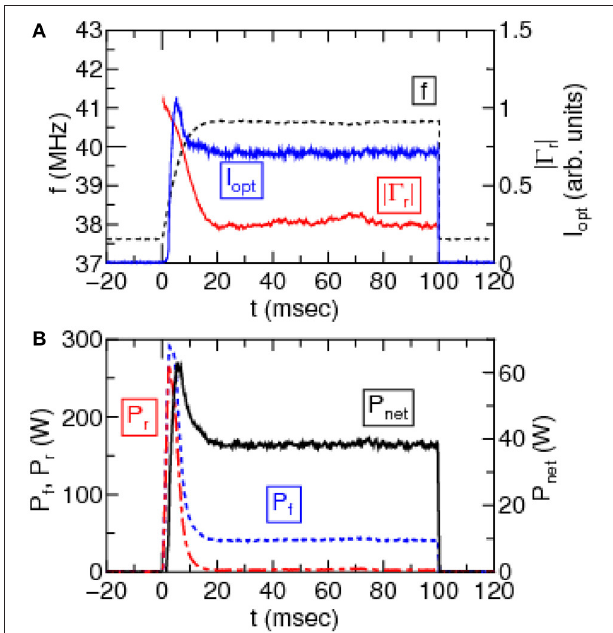
FIGURE 7 | Temporal evolutions of (A) the rf frequency f , the optical emission intensity I opt , and the reflection coefficient | Γ r |, and (B) the rf powers P f , P r , and P net . The initial frequency and the target value of the net power are chosen as f 0 37.6 MHz and P set 40W, respectively. = =